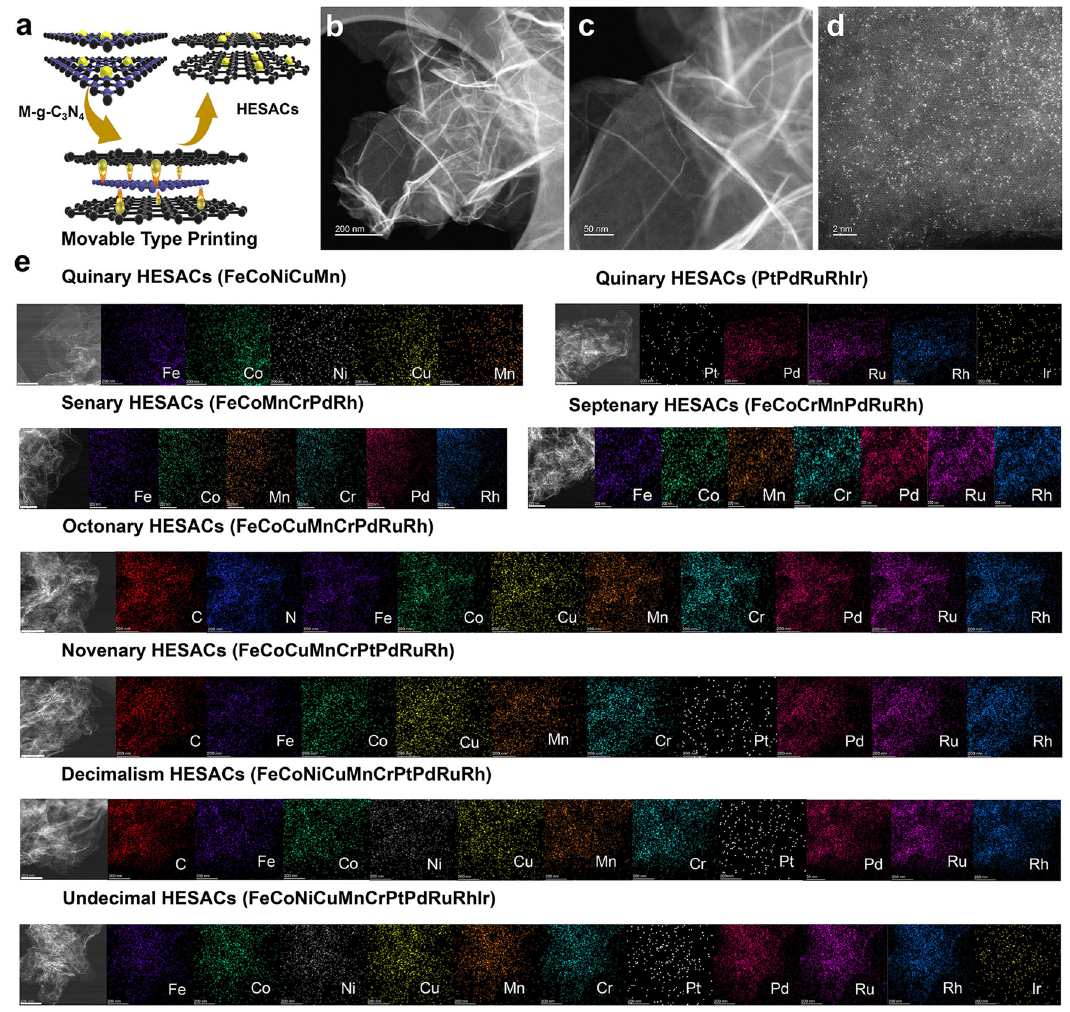
Fig. 1 | Synthesis of HESACs by movable type printing method. a Illustration of movable type printing method to prepare HESACs. b , c HAADF-STEM and ( d ) AC